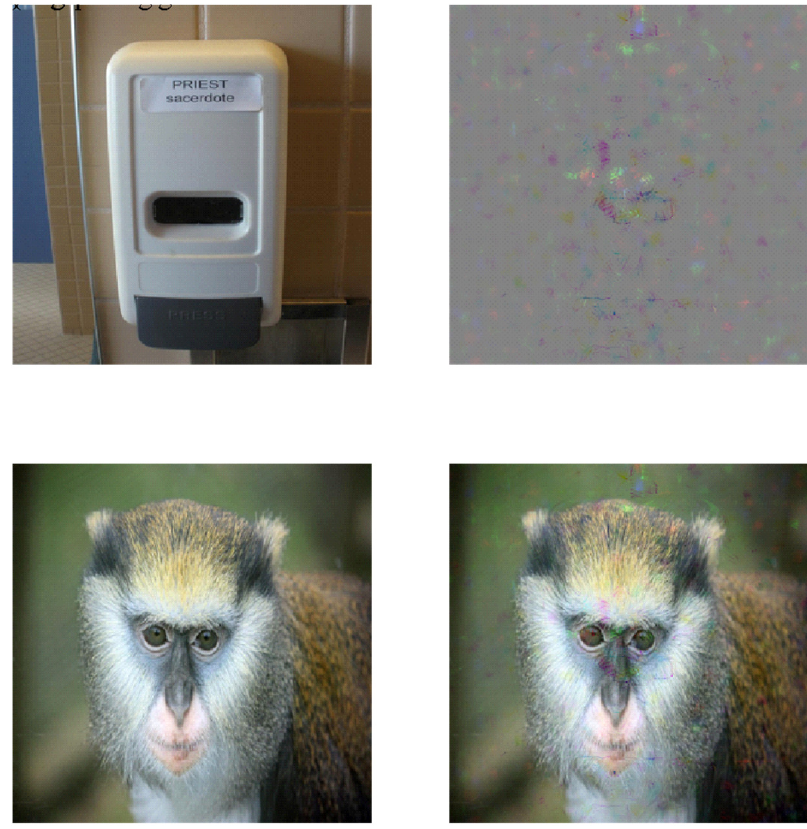
Figure 1. An example of an image adversarial examples